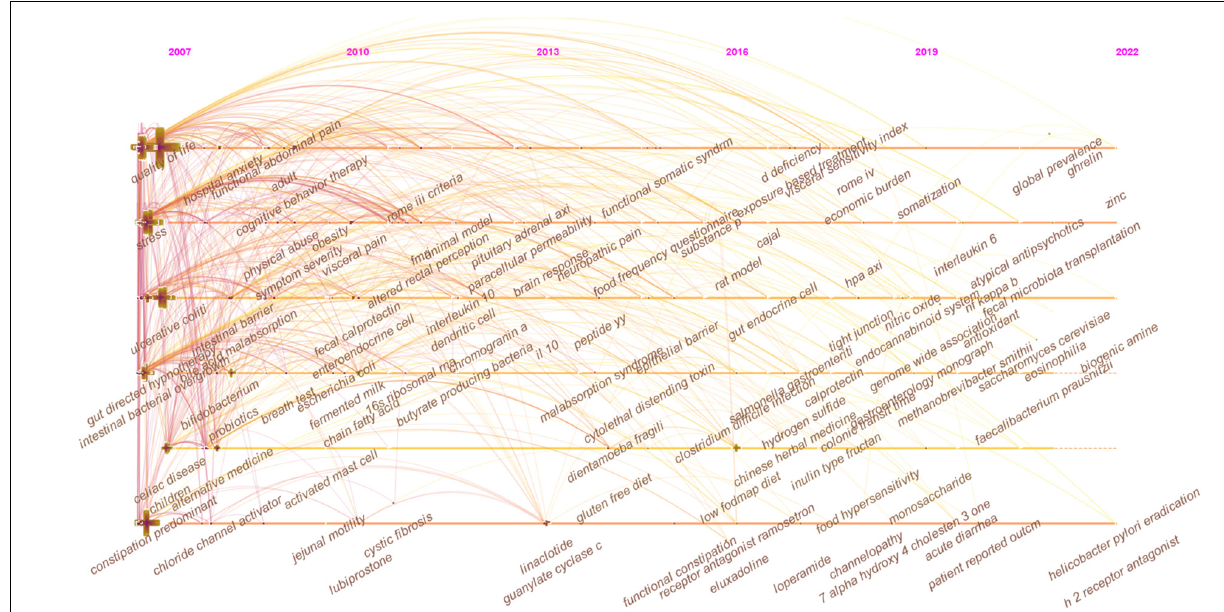
FIGURE 7 | The timeline view of keywords in IBS research.